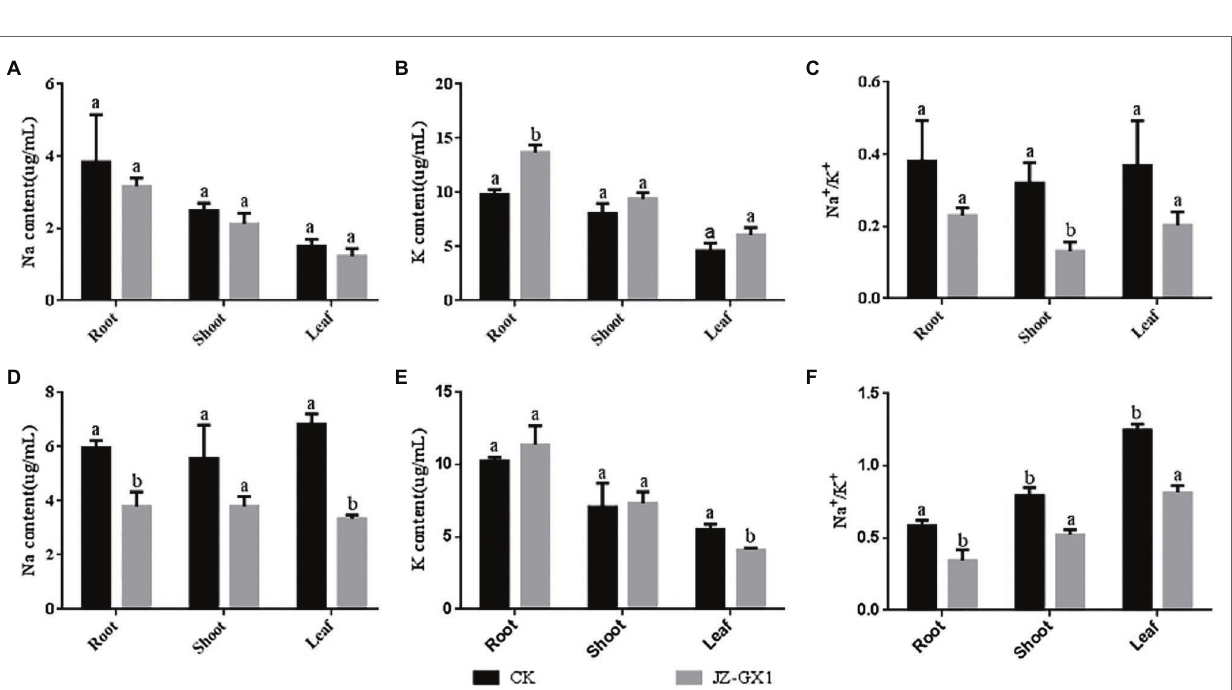
FIGURE 3 | Effect of volatile gases of R. aquatilis JZ-GX1 on the malondialdehyde (MDA) content and proline osmoregulatory substance content in R. pseudoacacia . (A) MDA; (B) proline.